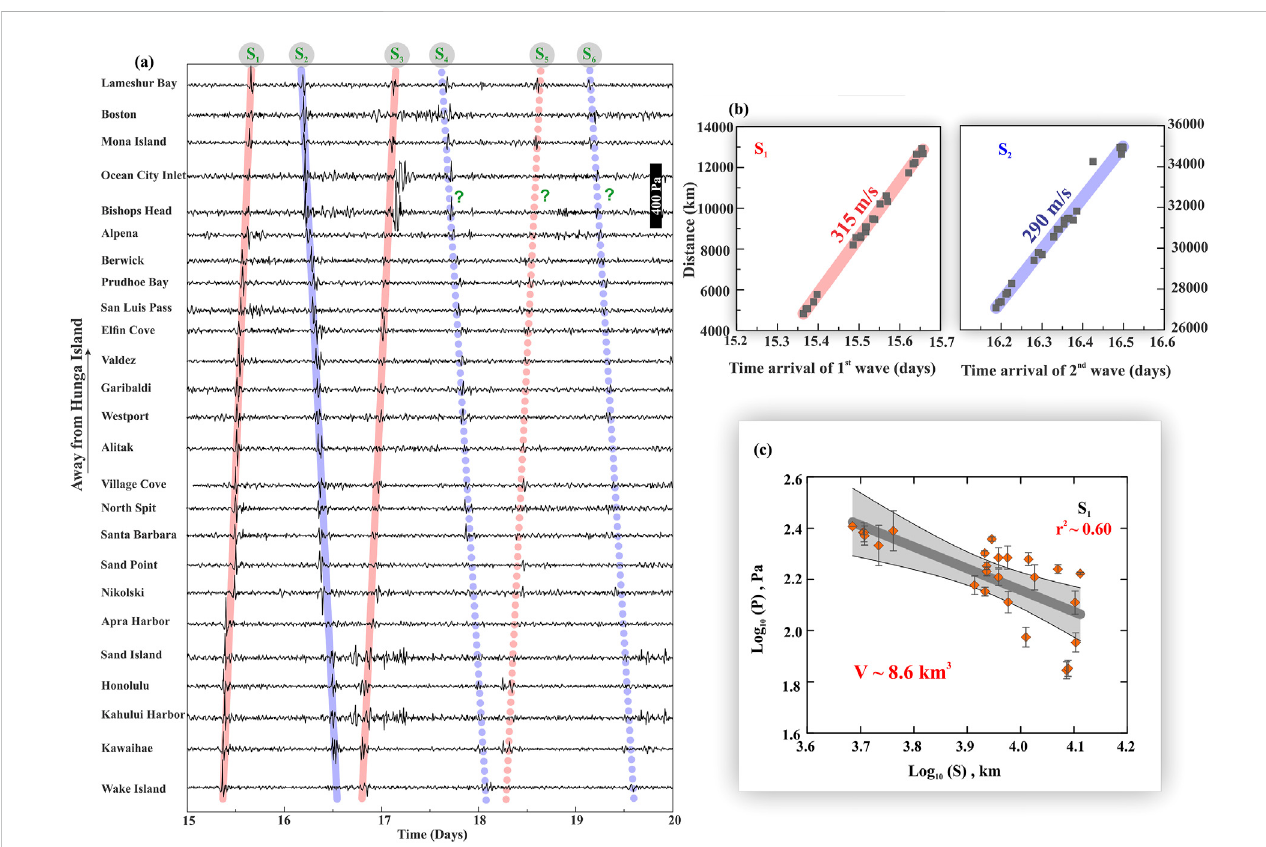
FIGURE 2 (A) Barograms of 25 weather stations mapped after the volcanic explosion from 15 to 20 January 2022. Barograms are arranged by increasing distance from the location of the eruption, through which the shift of the pressure disturbance with time is indicated clearly. (B) Distance versus arrival time of the fi rst two waves S 1 and S 2 in all 25 weather stations. (C) Logarithmic value of pressure change on the arrival of fi rst wave S 1 versus the logarithmic value of the distance of the stations from Hunga Tonga. Note that the volume of the material ejected from the eruption is ~8.6 km 3 , derived from pressure change